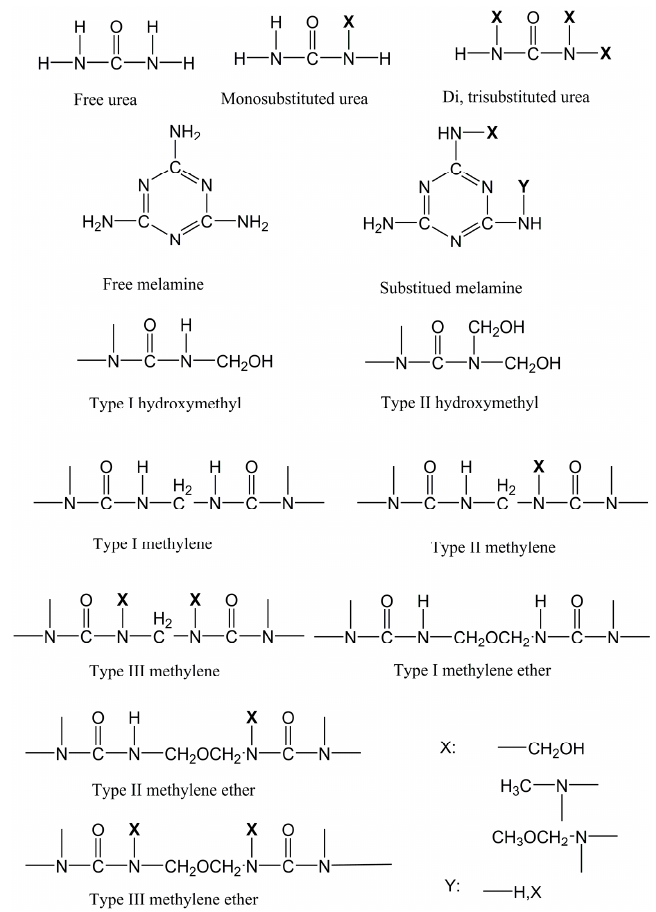
Figure 3. Chemical structure of various carbon groups.